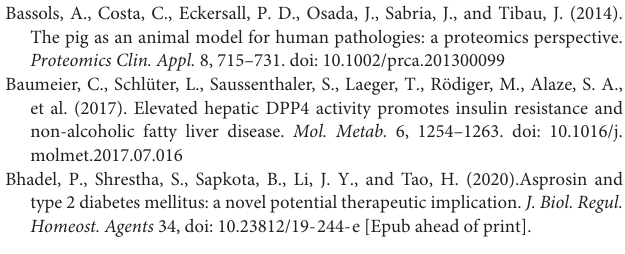
Supplementary Figure 1 | All second-order mass spectrum matching figures of target protein candidate peptides. Supplementary Figure 2 | Skyline analysis of target peptide PRM results. Supplementary Figure 3 | Validation of the expression of DEGs/DEMs by qRT-PCR. Data from qRT-PCR are shown as column and Y -axis on the left, while the data from RNA-seq are shown as line and Y -axis on the right. Data are represented as mean ± SEM, n = 3 per group. Supplementary Figure 4 | Validation of the expression of DEPs by parallel reaction monitoring (PRM). Supplementary File 1 | List of expressed genes and miRNA during Ningxiang pig liver development. Gene ID, TPM value, gene name, GO/KO ID, position, and description of all acquired genes. Supplementary File 2 | List of all miRNA sequences identified during Ningxiang pig liver development. Supplementary File 3 | Quality control analysis of the miRNAome. Supplementary File 4 | List of expressed proteins during Ningxiang pig liver development. Protein ID, abundance value, description of all acquired proteins. Supplementary File 5 | Kyoto Encyclopedia of Genes and Genomes pathways for upregulated and downregulated DEPs from N90 vs. N30 d and N210 vs. N90 d. Pathways marked gray background represent significant enrichment, while other terms represent non-significant enrichment. Supplementary File 6 | Kyoto Encyclopedia of Genes and Genomes pathways were identified by KEGG pathway analysis of hepatic overlapping differentially expressed (DE) mRNAs from three comparison groups. Supplementary File 7 | The relationship of miRNAs and mRNAs regulatory networks based on profile III–profile IV. Supplementary File 8 | List of protein interaction network node attribute. Supplementary File 9 | Data analysis of PRM quantitative in the target peptide section. The yellow bottom represents the internal control protein alpha-actinin-1. Supplementary File 10 | Primers of quantitative real-time